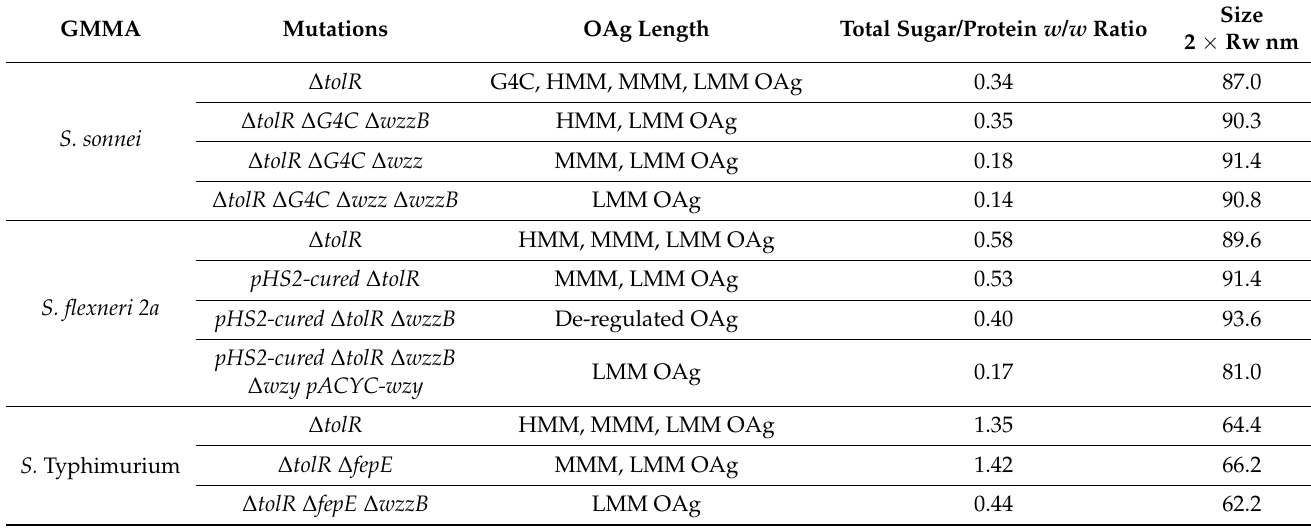
Table 2. Analytical characterization of GMMA displaying OAg populations of different length.